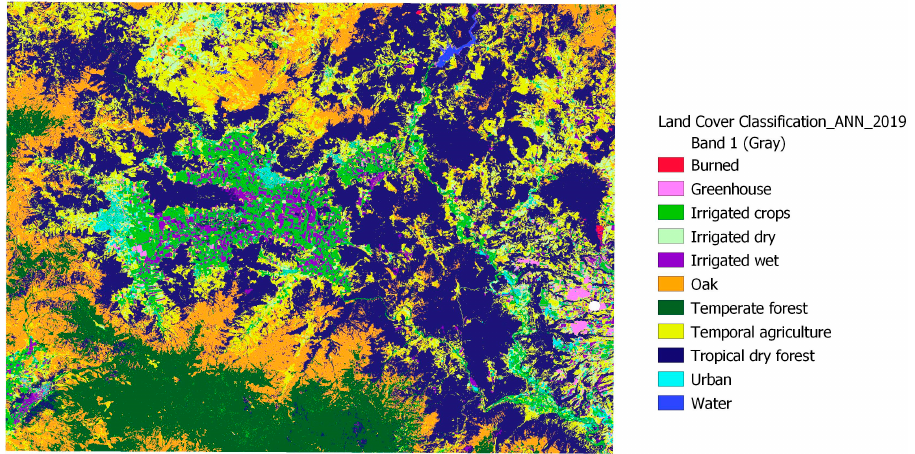
Figure A3. Land cover classification using ANN for 2019. Irrigated crops is short for Irrigated agri- culture with crops; Irrigated dry is short for Irrigated agriculture without crops (dry); Irrigated wet is short for Irrigated agriculture without crops (wet); Temporal agriculture is short for Temporal agriculture with pasture; Oak is short for Oak forest.